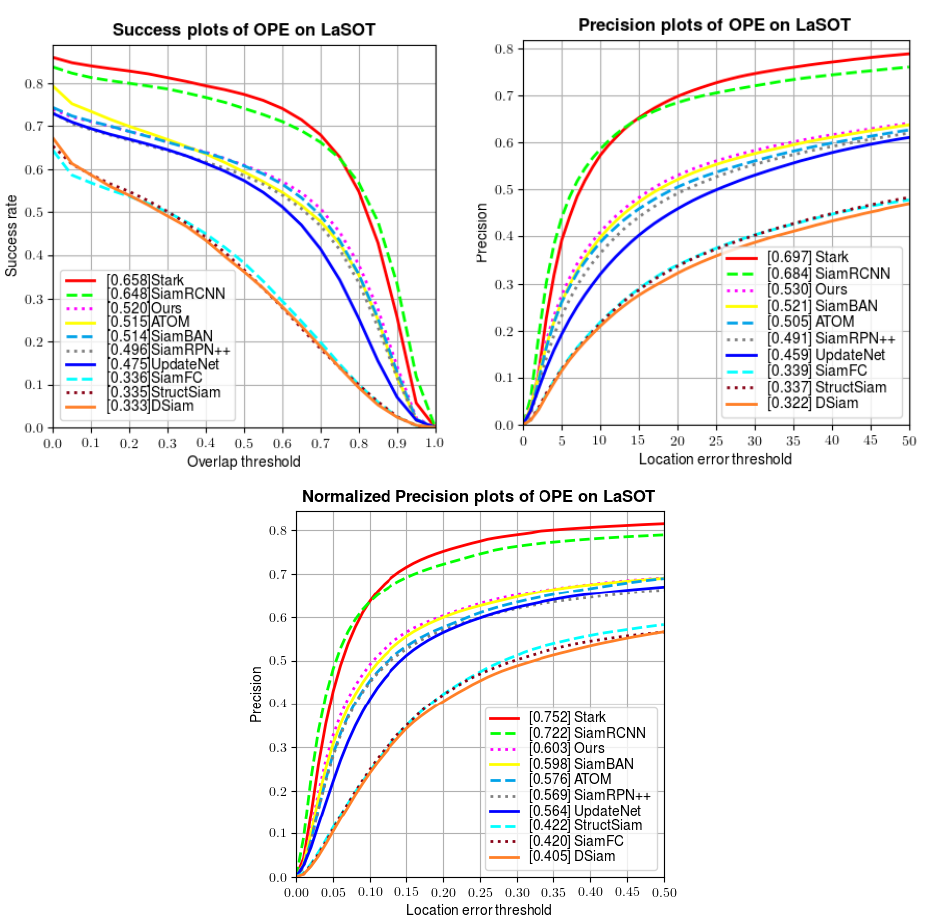
Figure 8. Comparison of tracking performance on LaSOT.